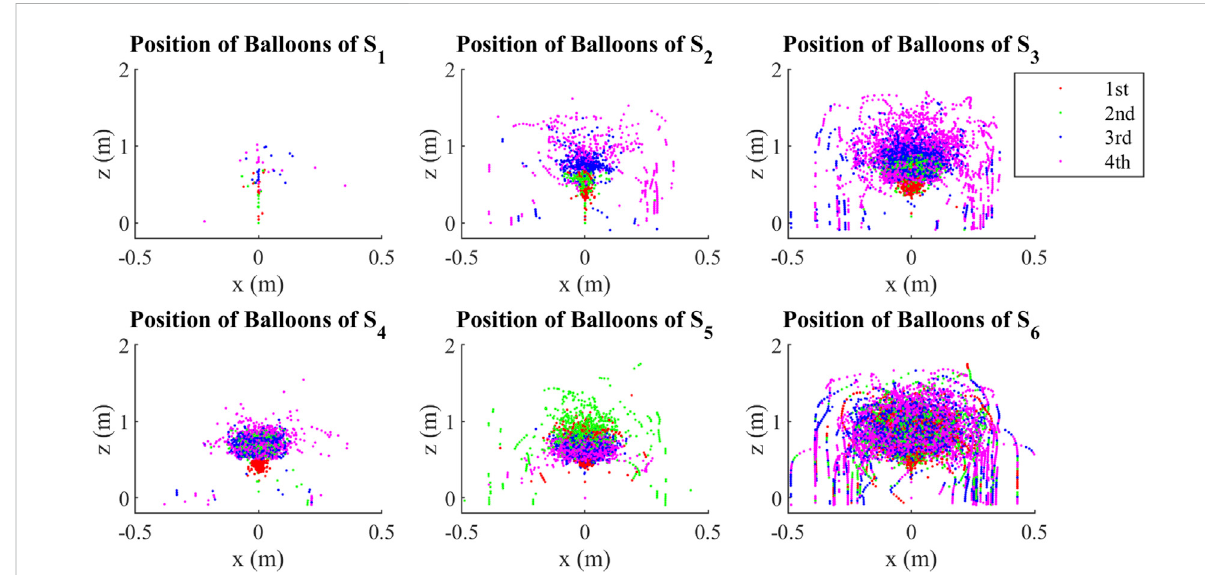
FIGURE 5 Positiondistributionofclustered states.Everydotshowsthepositionofaballataframe. Thedensityofdotsshowsthefrequenciesofclustered interaction states, and the distribution of dots in different colors shows the distribution of all the four balls from the strongest ( fi rst) to the weakest